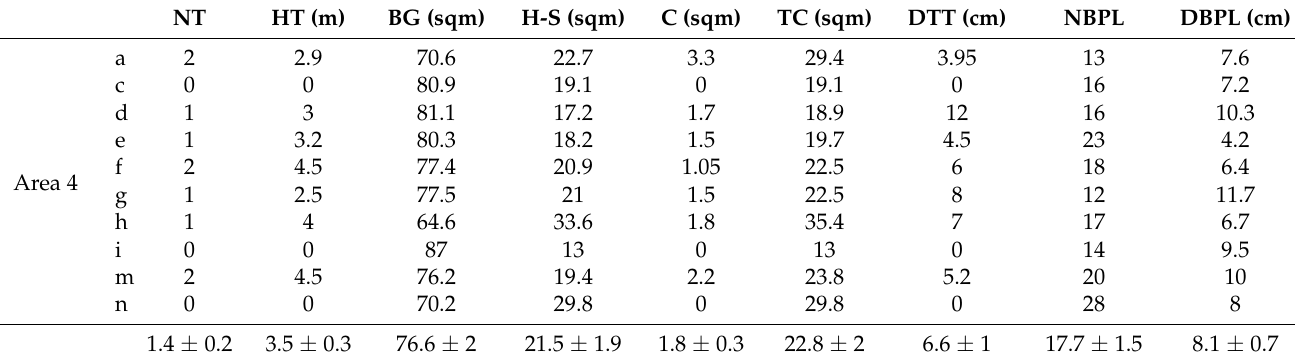
Table 1. Mean ( ± S.E.) of structural data from UAV measurements (descriptive statistics): NT = number of trees; HT = height of trees; BG = coverage of bare ground; H-S = coverage of herbs and shrubs; C = coverage of trees crown; TC = total vegetation coverage; DTT = diameter of tree trunk; NBPL = number of burned pine logs (on the ground); DBPL = diameter of burned pine logs (on the ground). All trees are cork oaks; (*) sum of H-S minus overlap; lowercase letters of the first column are plots